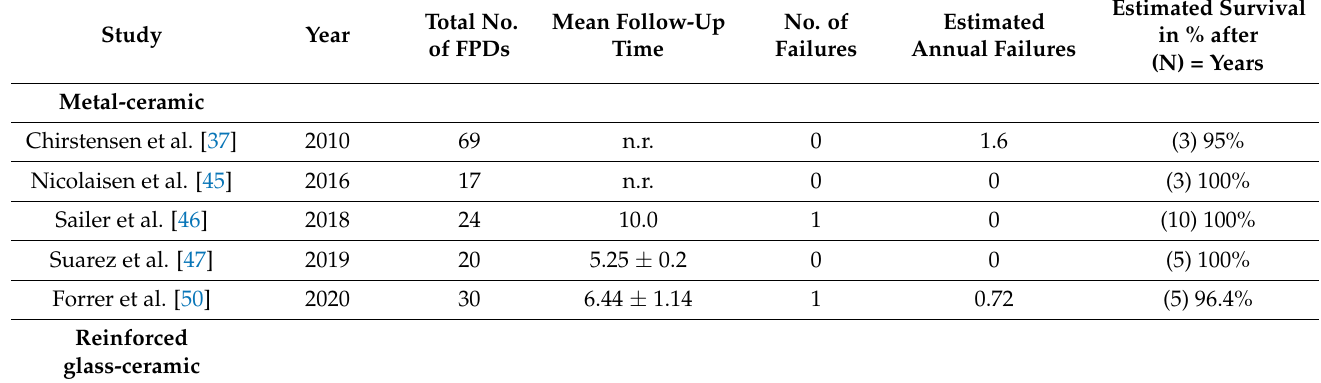
Table 2. Survival of metal-ceramic and all-ceramic fixed partial